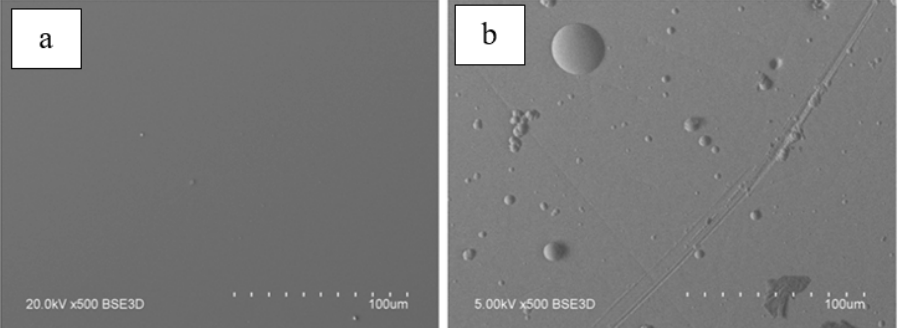
Figure 25. Surface micrographs of the coating based on alumina ceramics of different composition synthesized at different power densities: ( a )—1 kW/cm 2 ; ( b )—10.5 kW/cm 2 . Figure 24. Evaporation rate during electron-beam evaporation of the target of a type of alumina ceramics vs. the electron-beam power density. Beam current up to 200 mA; pressure 10 Pa, beam diameter 5 mm.